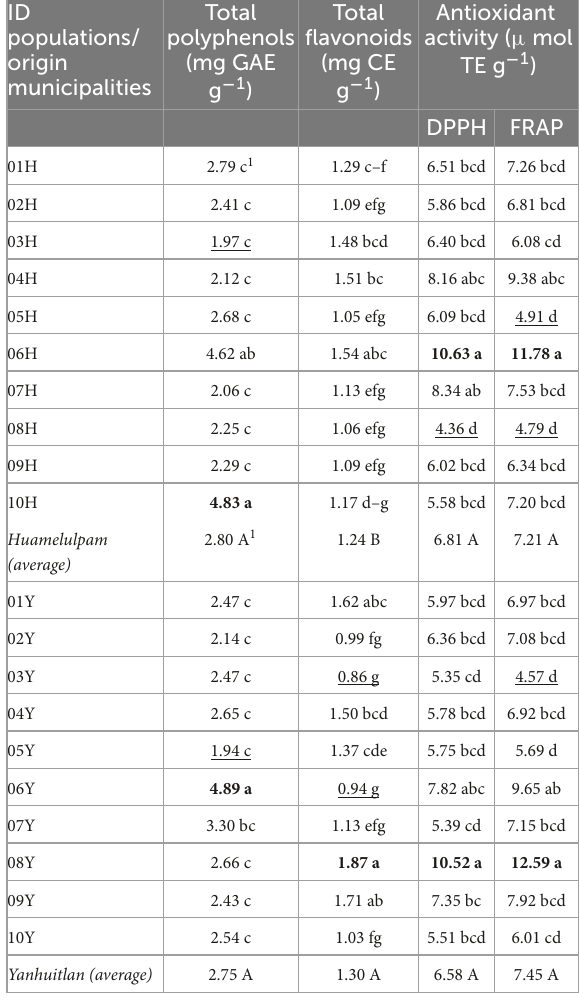
TABLE 2 Variation in soluble solid contents, pH, sugars, and protein content between C. ficifolia populations from two municipalities of Oaxaca, Mexico.